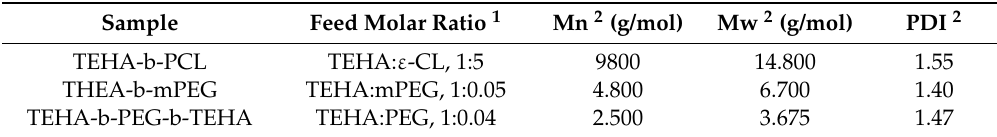
Table 1. Molecular characteristics of TEHA-b-PCL, TEHA-b-mPEG, and TEHA-b-PEG-b-TEHA block copolymers.